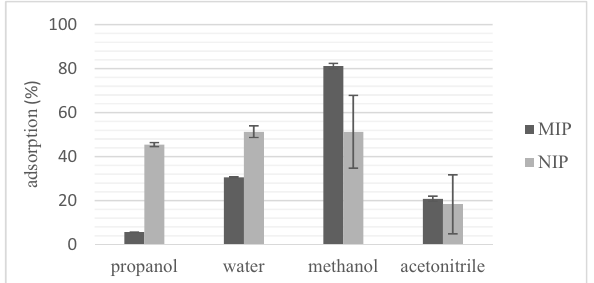
Figure 4: Batch adsorption test